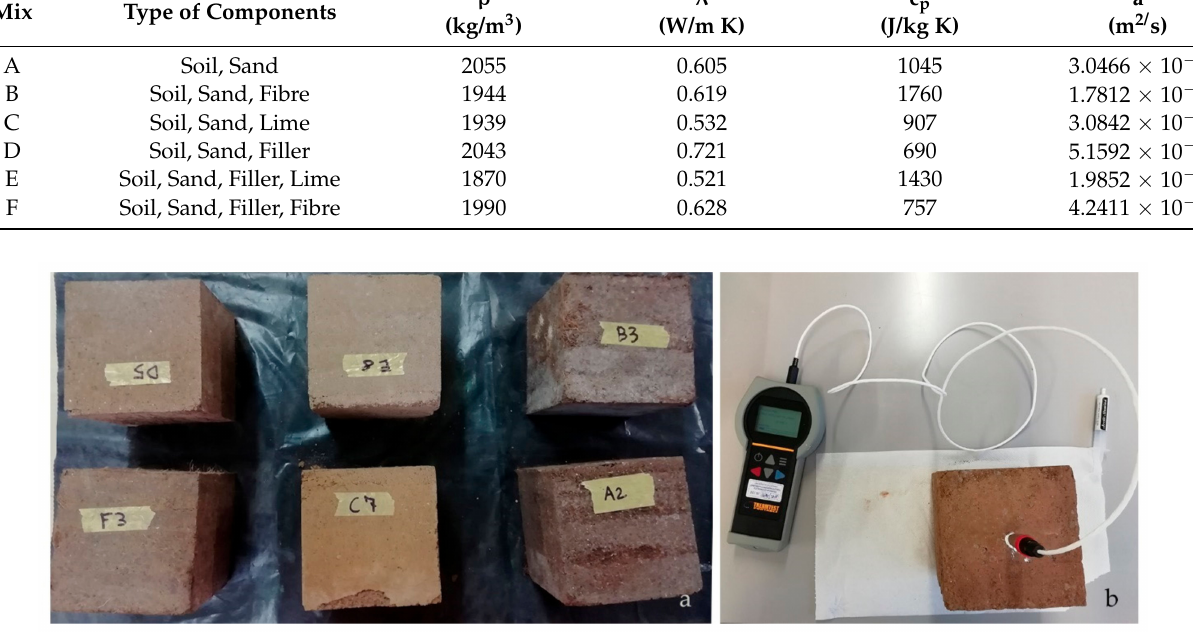
Figure 1. ( a ) Rammed earth samples; ( b ) Thermal conductivity measurements.